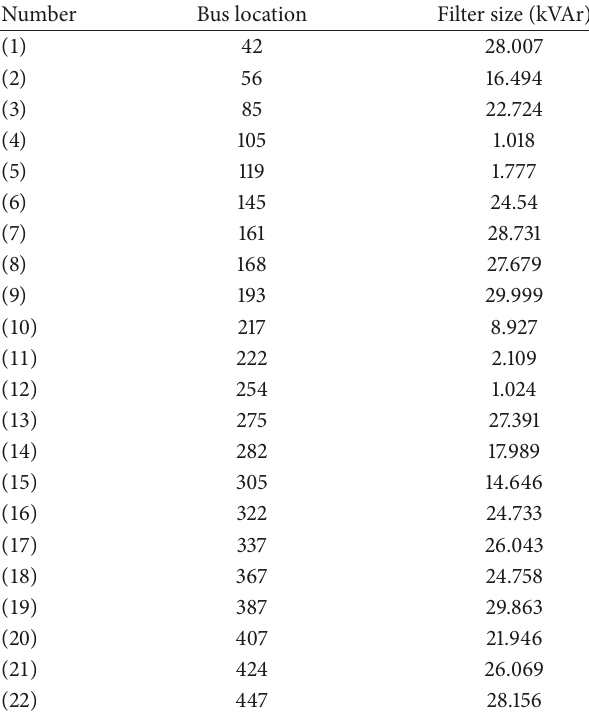
Table 4: Bus location and filter size after 500 iterations.